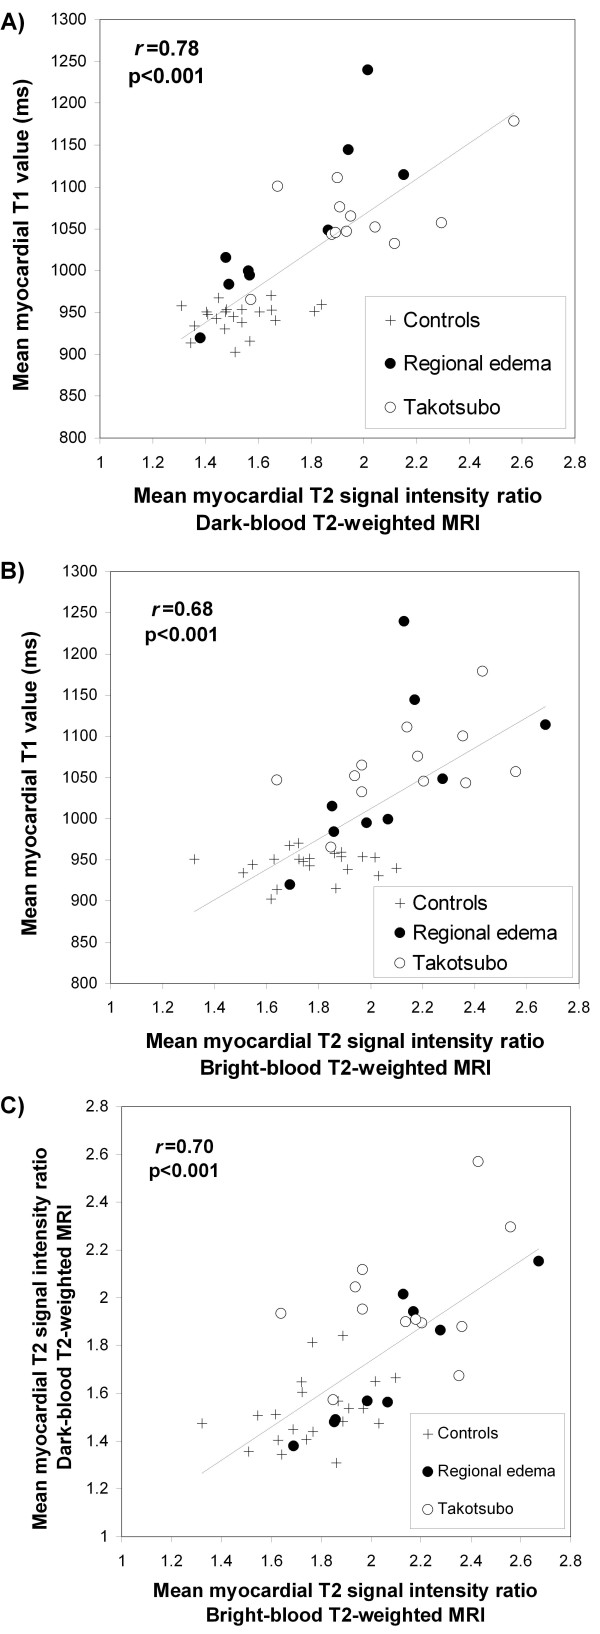
Relationship between: (A) myocardial T1 values and T2 signal intensity (SI) ratio* derived from dark-blood T2w-CMR; (B) myocardial T1 values and T2 SI ratio derived from bright-blood T2w-CMR; (C) myocardial T2 SI ratio dark-blood vs. bright-blood T2w-CMR. *T2 SI ratio = SImyocardium/SIskeletal muscle.